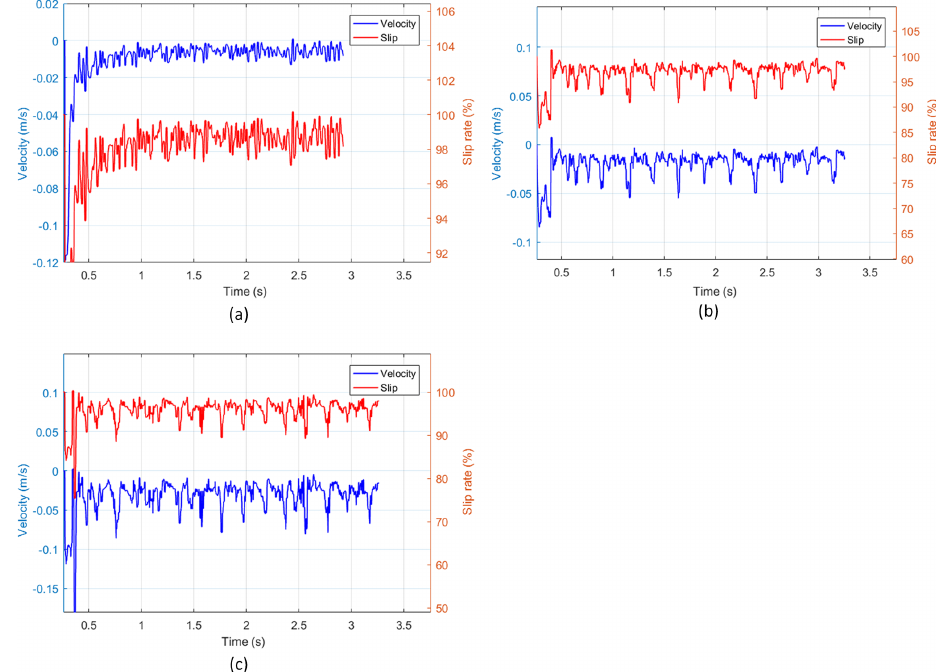
Figure 19. Speed and slip rate corresponding to different screw speeds. (a) ω = 180rpm. (b) ω = 240rpm. (c) ω = 300rpm.